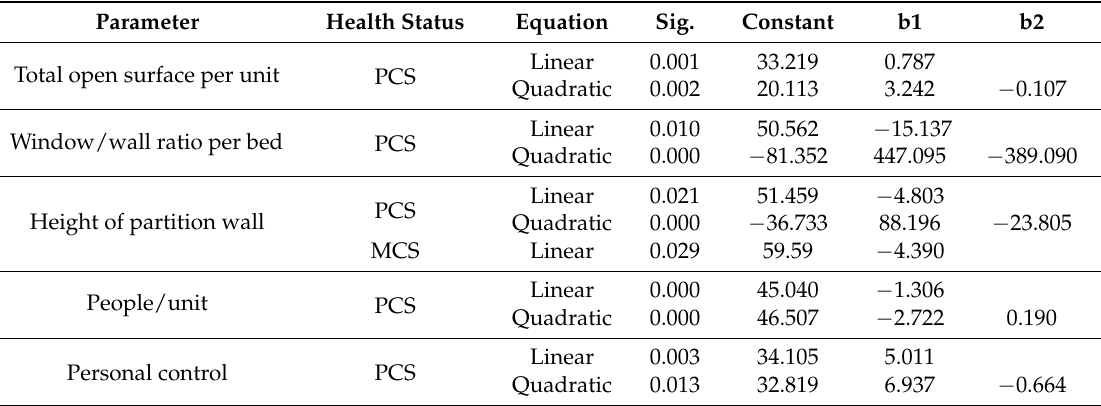
Table 3. Regression analysis between privacy and health status.